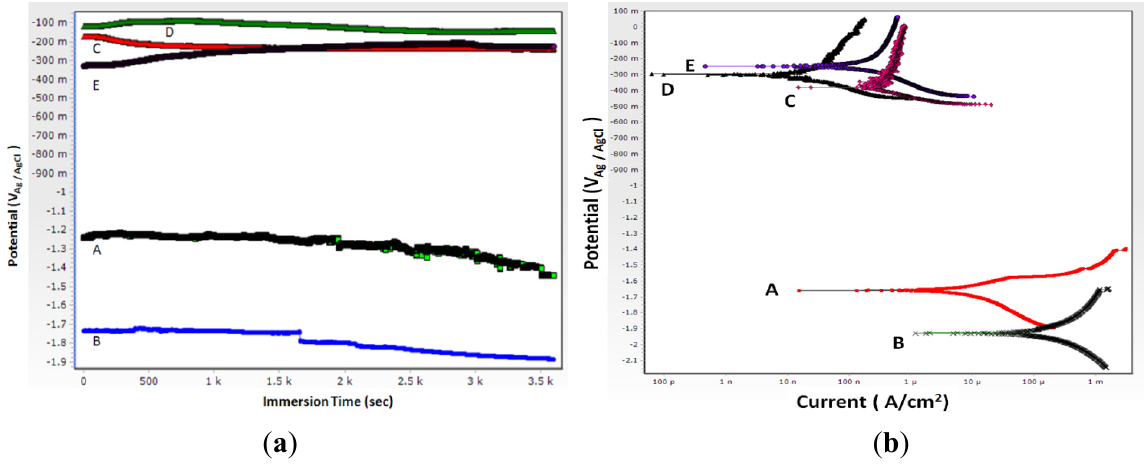
, no pre-test immersion 2 , 18 h pre-test 2 , 6 days pre-test immersion, 2